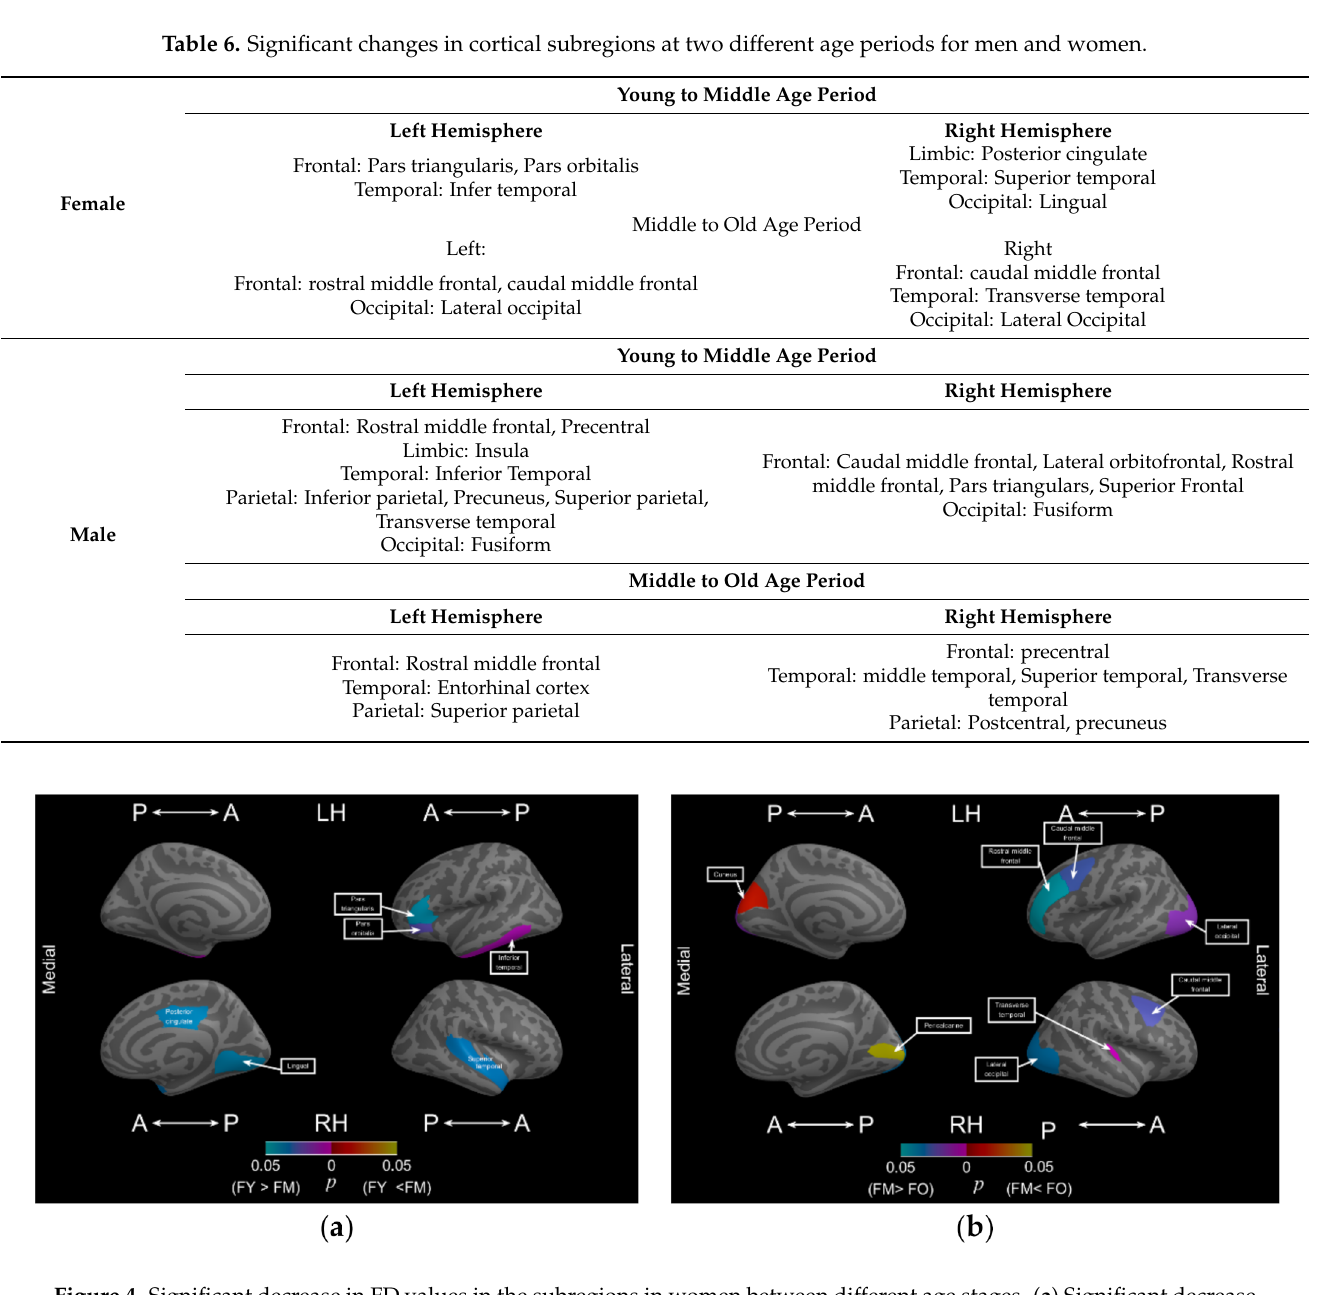
Figure 4. Significant decrease in FD values in the subregions in women between different age stages. ( a ) Significant decrease in FD values in the subregions in women in the young-age group compared with that in women in the middle-age group; ( b ) significant decrease in FD values in the subregions in women in the middle-age group compared with that in women in the old-age